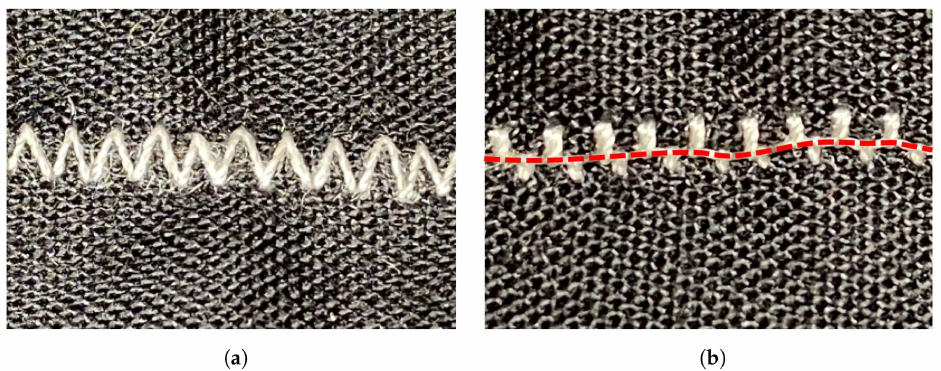
Figure 2. ( a ) A zigzag stitch is observed on the upper side of the fabric. ( b ) The same zigzag stitch as observed on the bottom side of the fabric. The dashed red line shows the bobbin